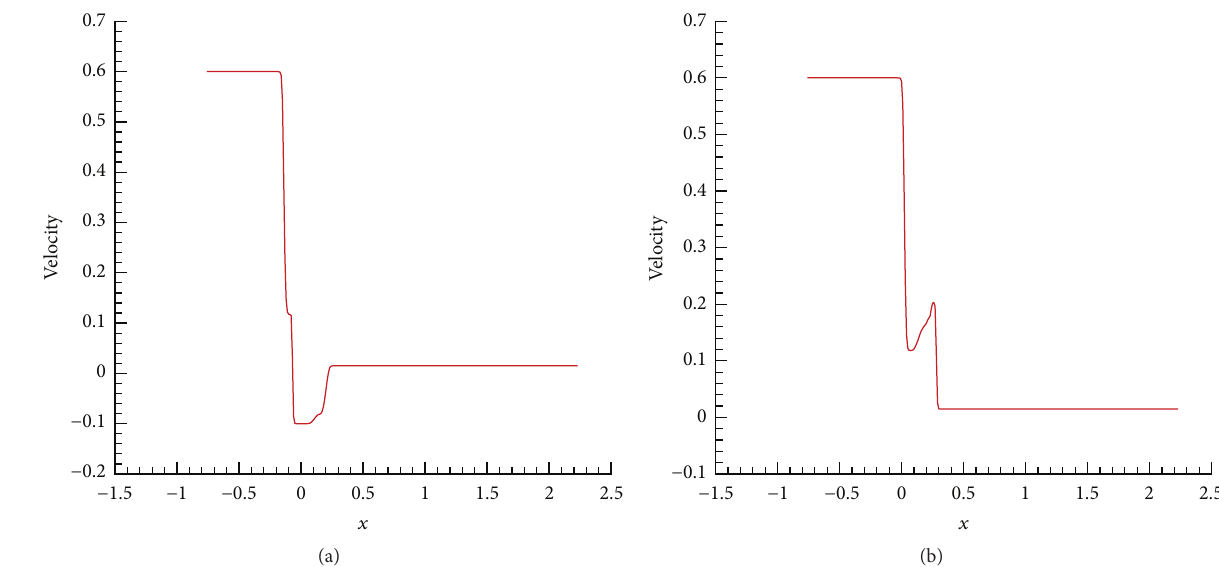
Figure 8: Numerical results of 𝑢 at 𝑡 = 0.8 (a) and 𝑡 = 2.9 (b) for Data